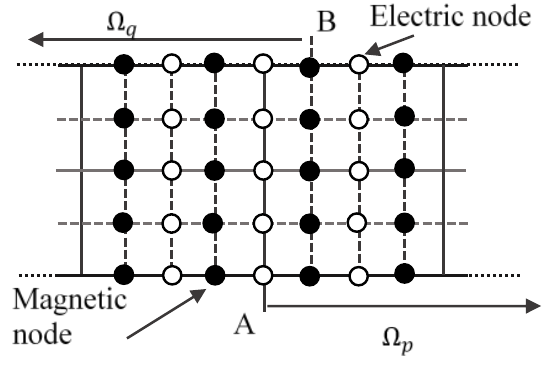
Figure 5. Electric and magnetic field nodes at virtual